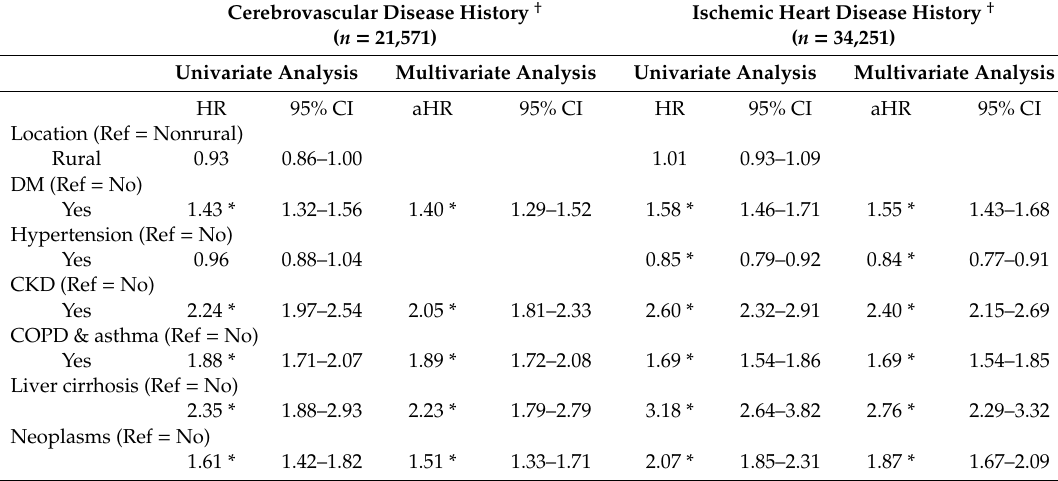
Table 4. Hazard ratio of all-cause mortality in a ff ected adults with previous histories of cerebrovascular and ischemic heart diseases before Typhoon